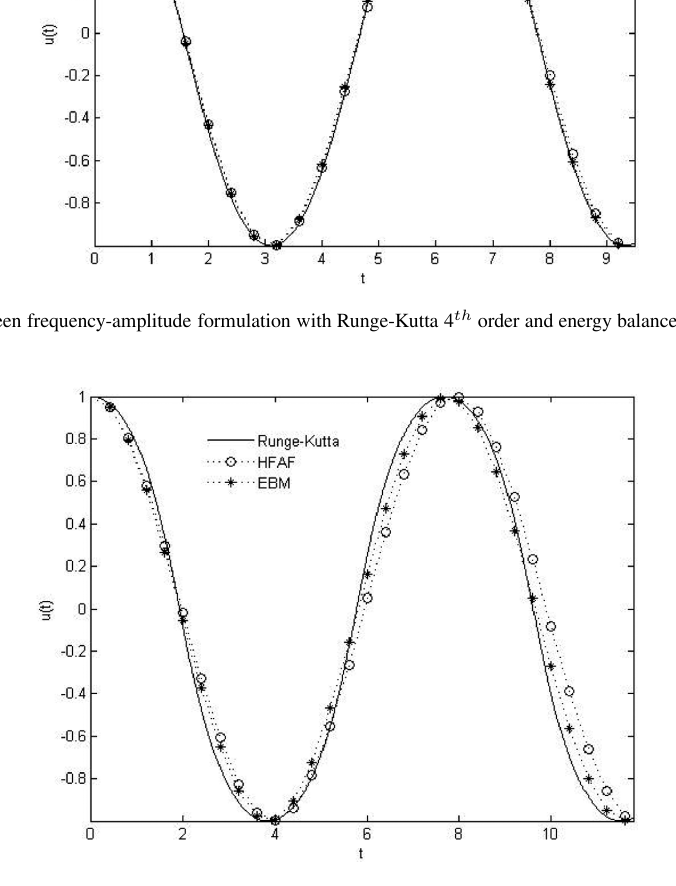
Fig. 10. The comparison between Frequency-amplitude formulation and Runge-Kutta 4 th order and energy balance solutions, when λ = 1 and A = 1, for the second